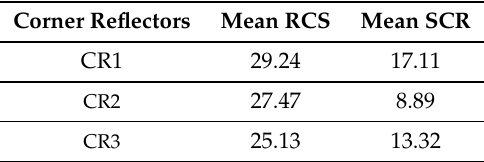
Table 3. Averages of RCS (dBm 2 ) and SCR (dB) estimated in 7 Sentinel-1 descending images,